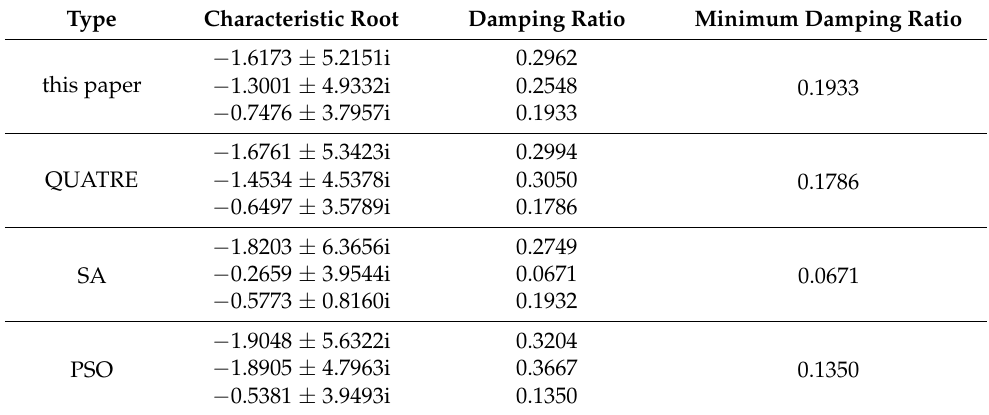
Table 5. Characteristic root and damping ratio of the system after designing PSS by different methods.